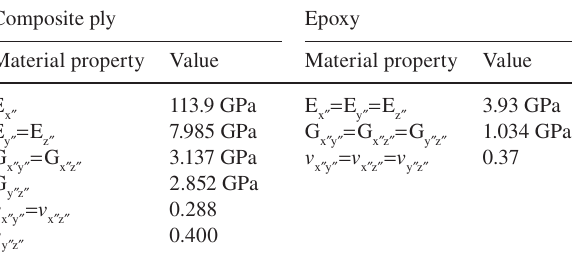
Table 1 Material properties of NCT/301 graphite-epoxy composite ply and epoxy materials.